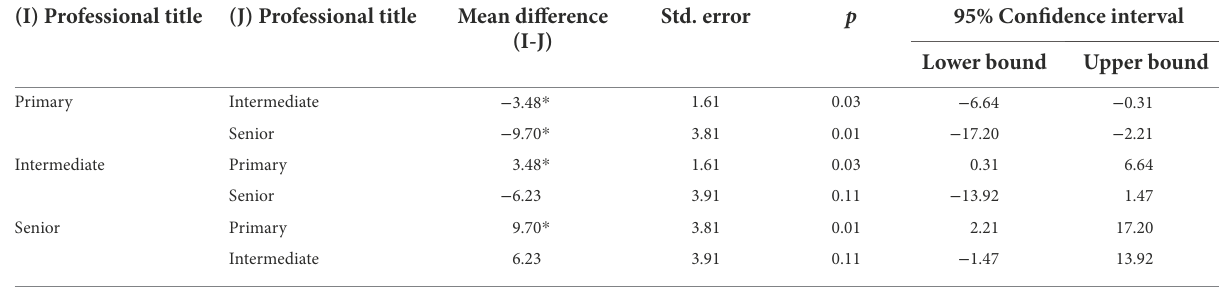
TABLE 3 Multiple comparisons of psychological capital scores of nurses with different professional title.